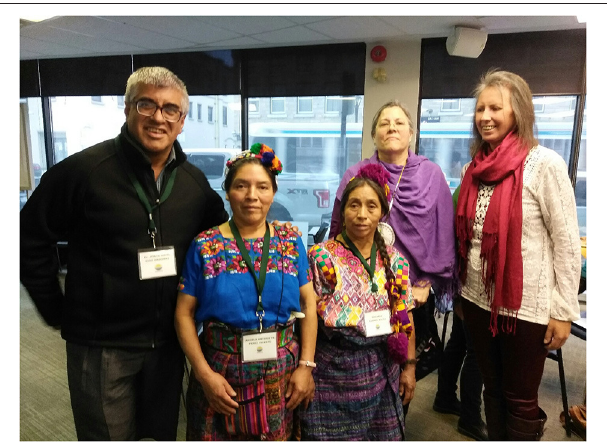
FIGURE 6 | From left to right: Dr. Diaz, Angela Antonietta Perez Vicente and Nazaria Ajamel Xiloj from Momostenango, Guatemala, with Dorothy Green from Kenhte:ke Midwives Tyendinaga Mohawk Territory (in purple shawl) and Lynn Brant, nurse practitioner and community advocate—two Mohawk women offering support for traditional Indigenous knowledge exchange. Photo in Kingston, Ontario provided by the Horizons’ Office (2017), used with